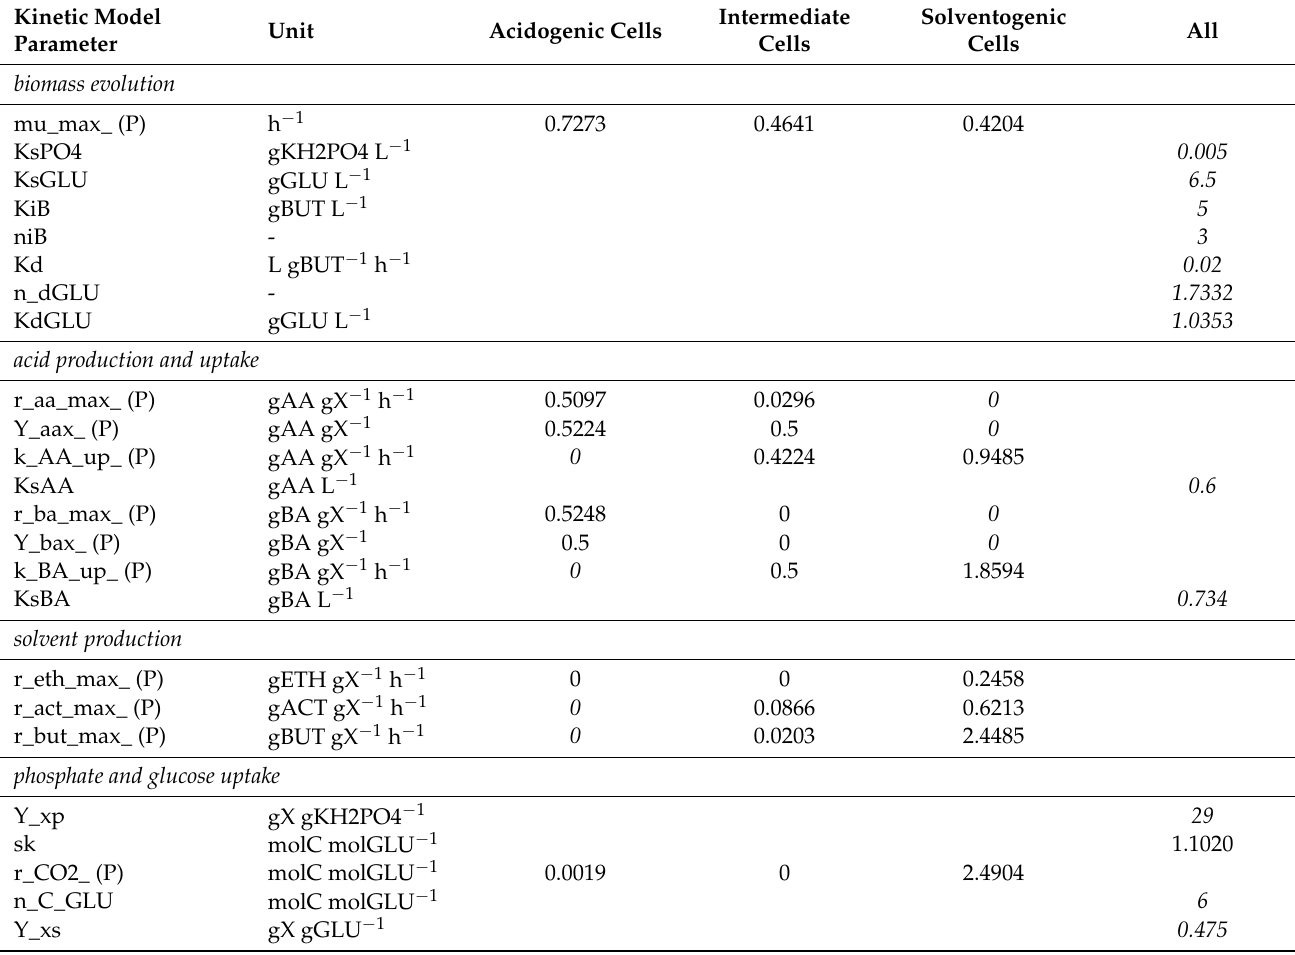
Table 2. Kinetic parameters of the mathematical model used for